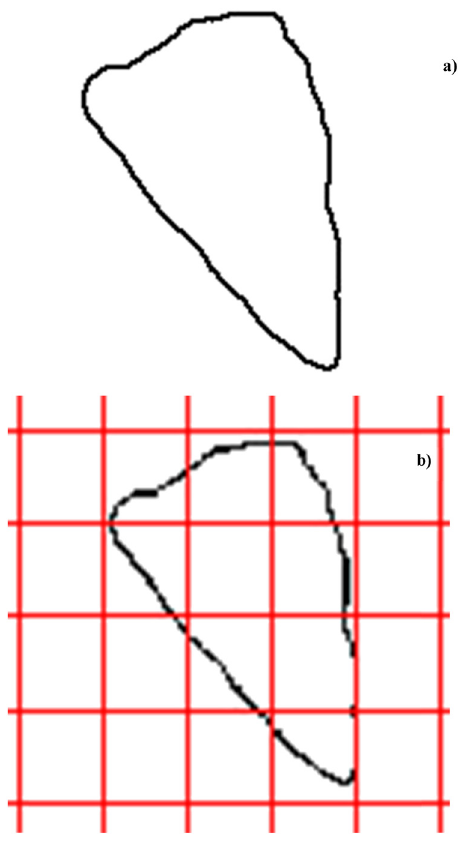
Figure 4: Outline of Type III recycled sand ( a ) and grid coverage on sand image ( b )